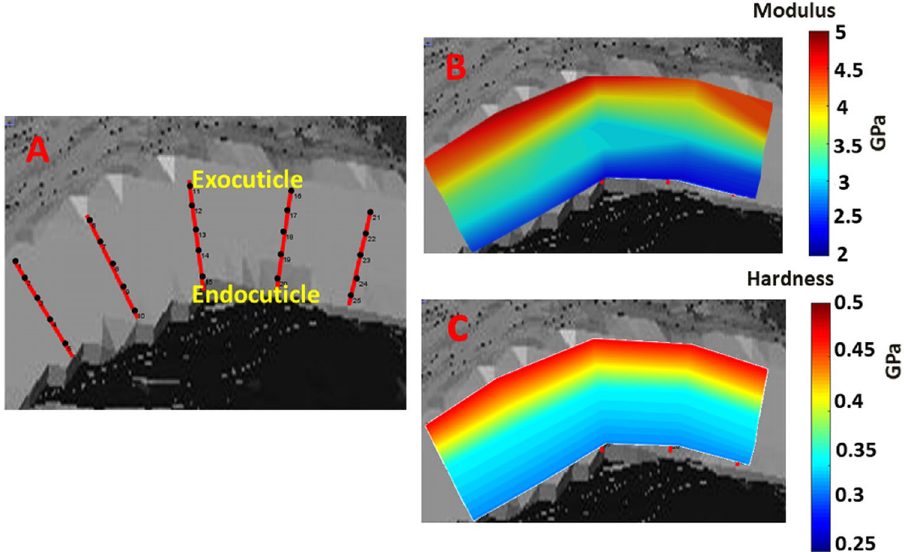
Figure 5. Quasi-static nanoindentation results at a cross section of the wasp stinger, ( a ) The approximate region at basal cross section where nanoindentation was performed, ( b ) Approximate nanoindentation sites, ( c ) Elastic modulus mapping, and ( d ) Hardness mapping. The cross section of the wasp stinger has hierarchical laminated structure and the mechanical properties are reduced from exocuticle to endocuticle.